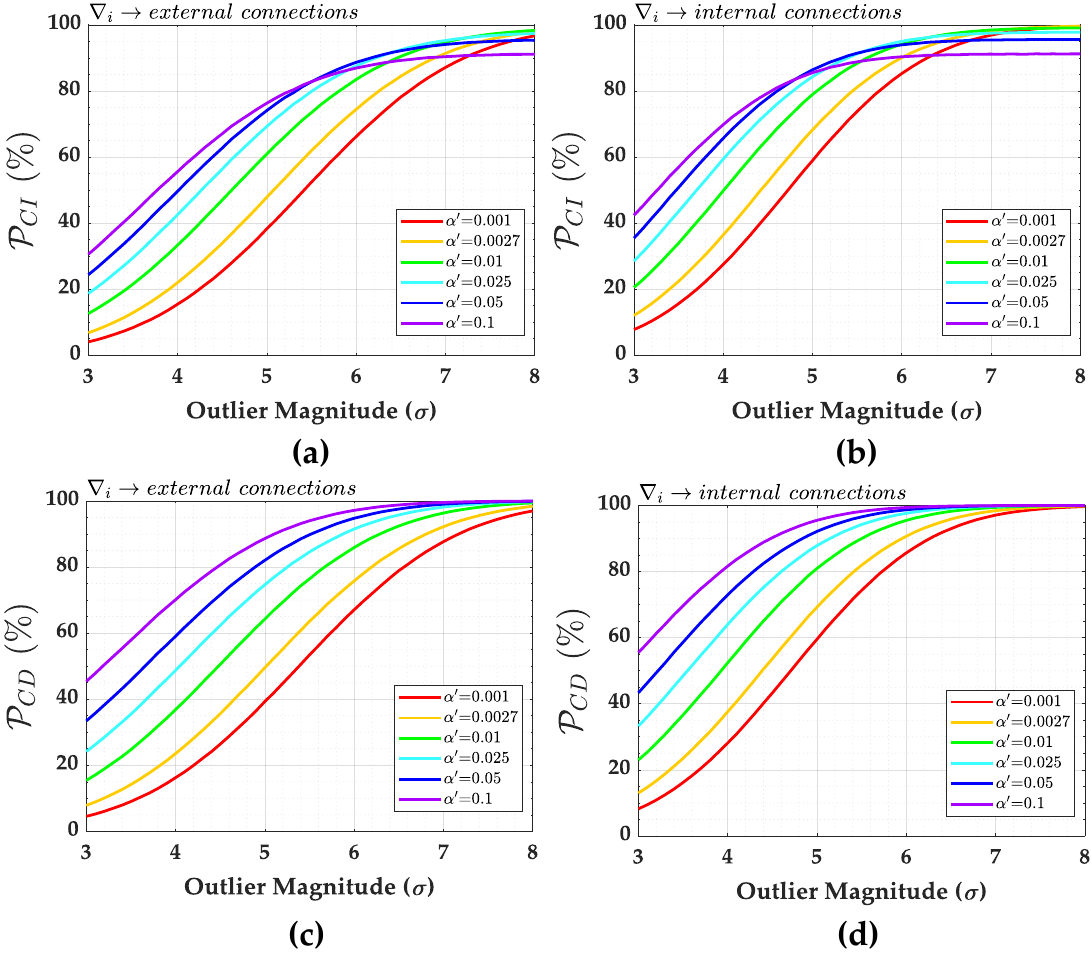
Figure 8. Probability of correct identification ( P CI ) and correct detection ( P CD ) for network ( a ): ( a ) P CI for the measurements constituting external connections. ( b ) P CI for the measurements constituting internal connections. ( c ) P CD for the measurements constituting external connections. ( d ) P CD for the measurements constituting internal